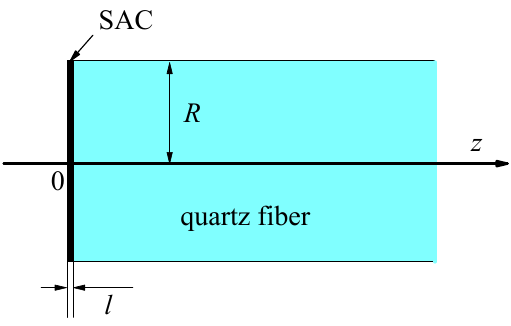
Figure 3. Schematic of a fiber with an SAC at the tip.